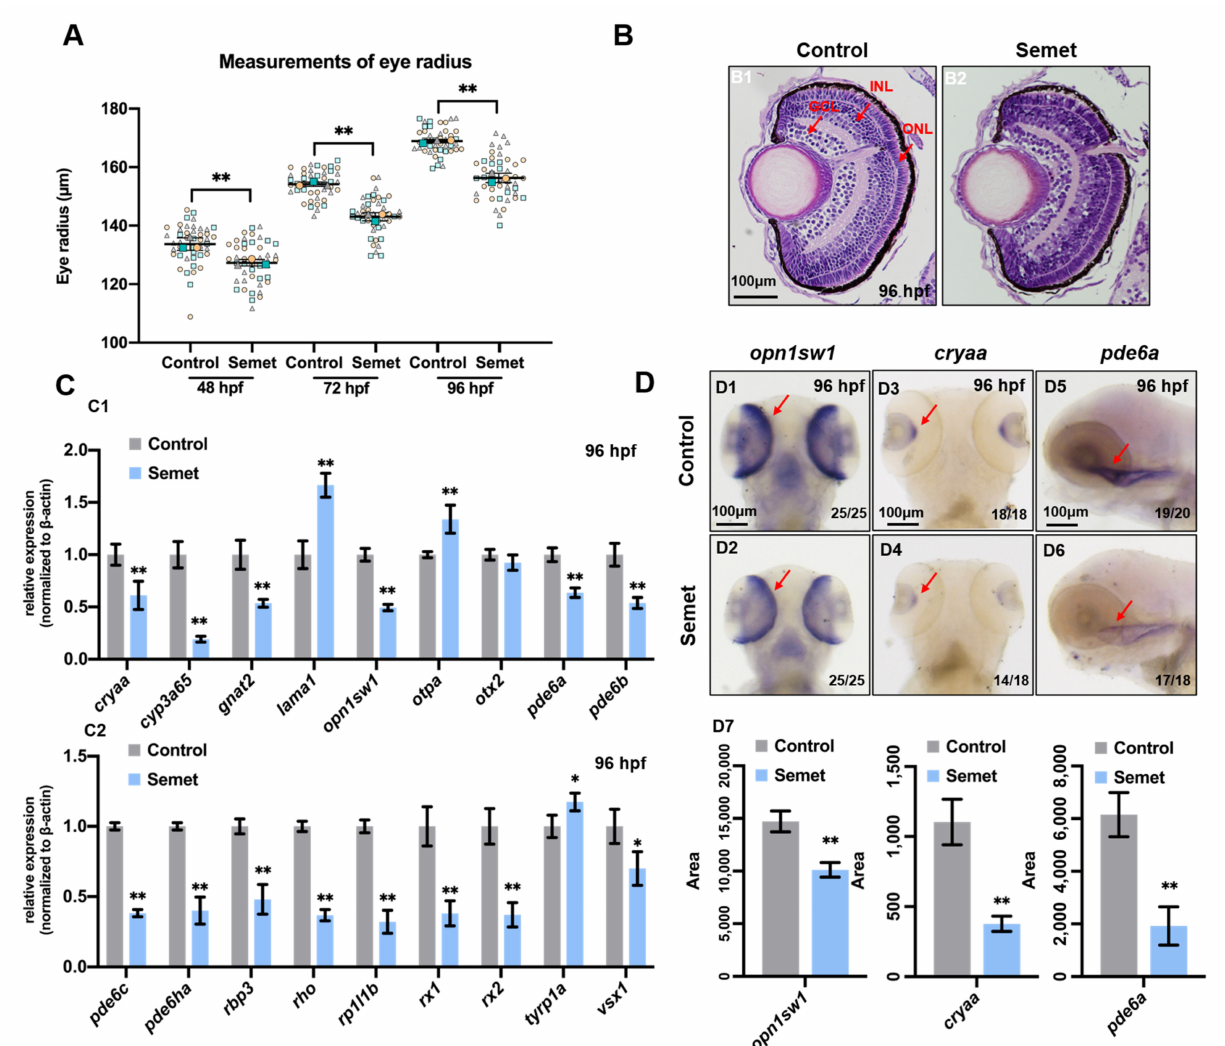
Figure 1. Eye developmental defects in selenium-treated embryos. ( A ) Measurement of eye radius of embryos from control and selenium-treated groups at 48 hpf, 72 hpf and 96 hpf. ( B ) H&E staining analysis of embryonic eyes from control and selenium-treated groups at 96 hpf (red arrows indicate GCL, INL and ONL layer of retina). ( C ) Expressions of eye marker genes in embryos from control and selenium-treated groups at 96 hpf ( C1 , C2 ). ( D ) WISH data of opn1sw1 , cryaa and pde6a in embryos from control and selenium-treated groups at 96 hpf ( D1 – D6 ). Quantification analysis of the